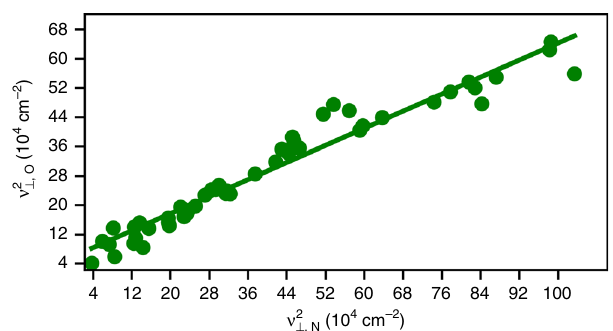
Fig. 3 DFT ν ⊥ normal mode frequencies for atomic O vs. N. The data include hollow, bridge, and atop site adsorption on the (111), (110), and (100) facets of Ag, Au, Cu, Ir, Pd, Pt, and Rh. The slope of the regressed line is 0.58 and the intercept is 59,800 cm − 2